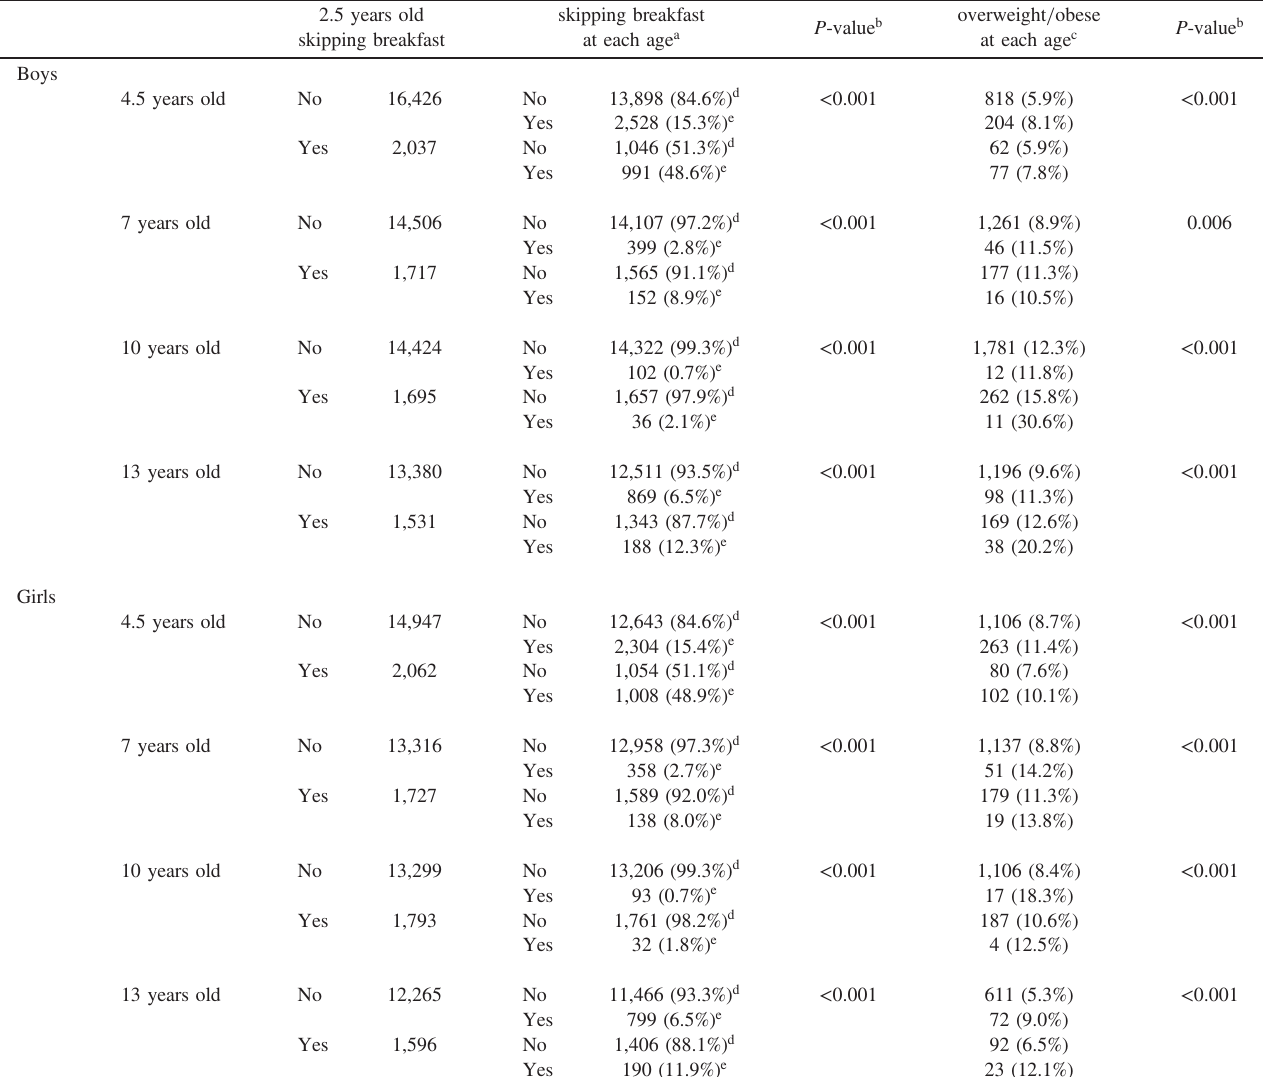
Table 3. Prevalence of skipping breakfast and overweight / obesity after 4.5 years old, according to skipping breakfast status at 2.5 years old 2.5 years old skipping breakfast skipping breakfast at each age